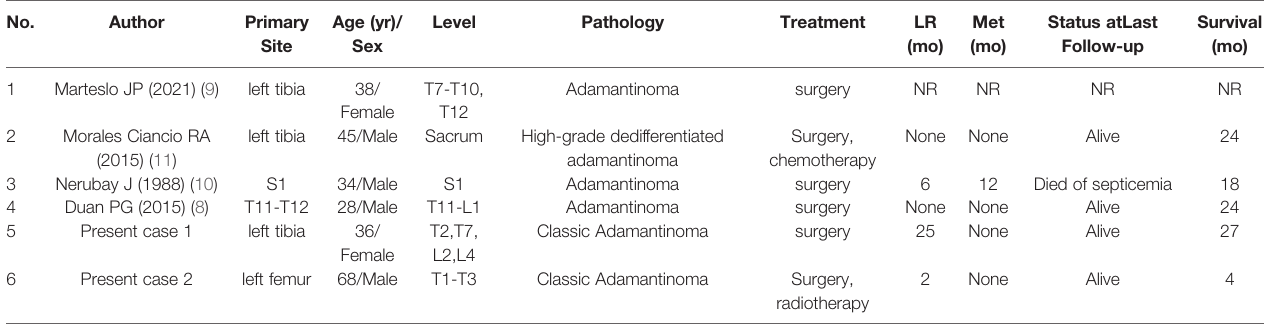
TABLE 1 | Literature Review of Adamantinoma of the Spine.